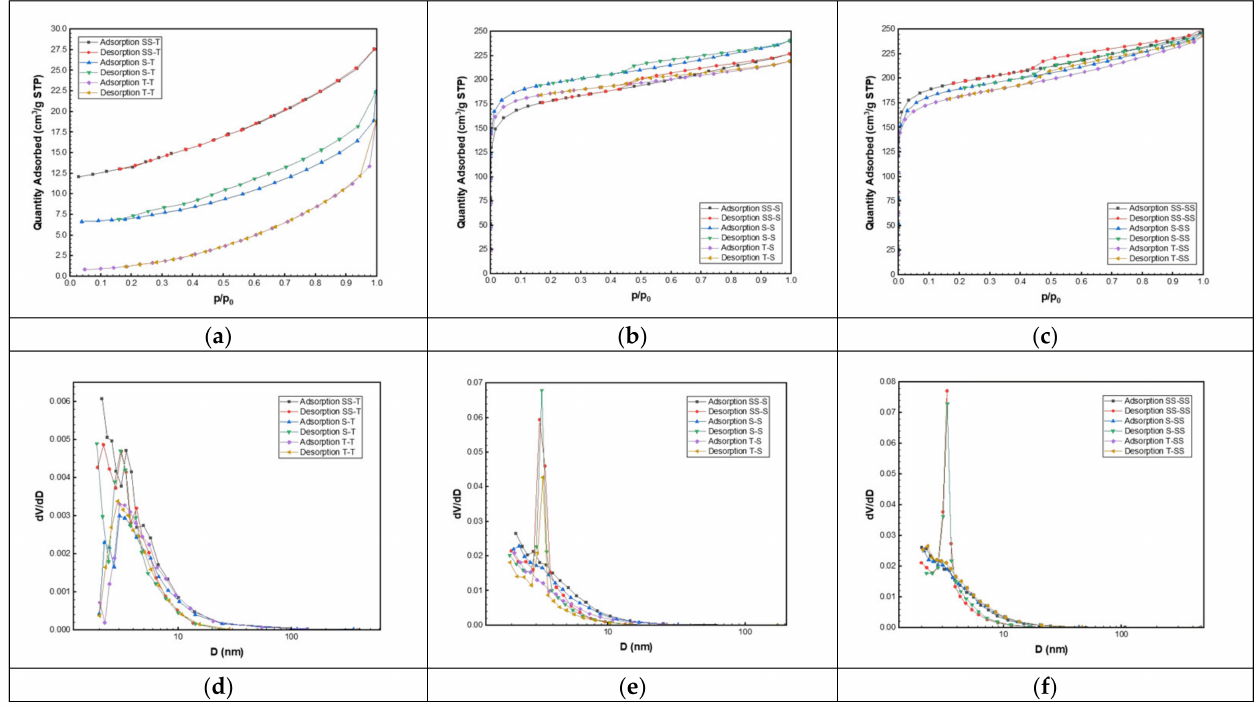
Figure 3. Nitrogen adsorption–desorption isotherm and pore size distribution of prepared activated carbon. ( a , d ) thermal activation; ( b , e ) saturated steam activation; ( c , f ) superheated steam